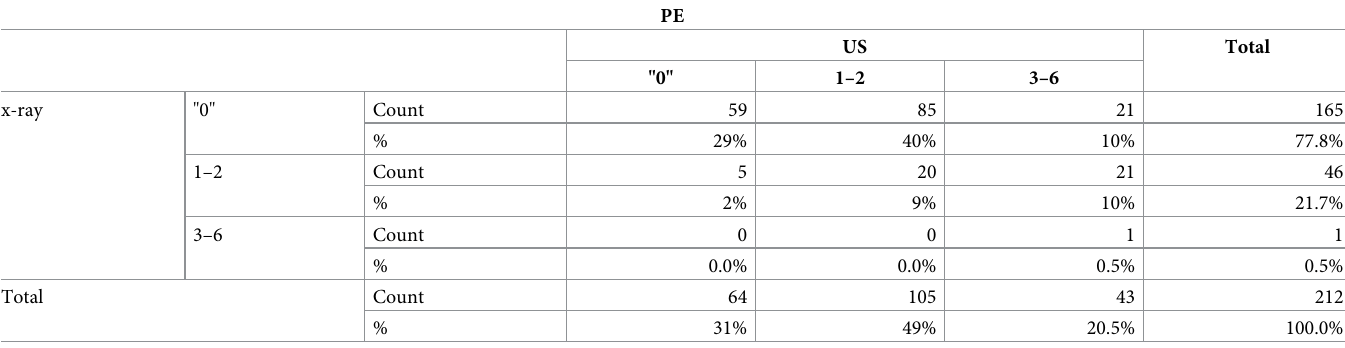
Table 3. PE: The agreement between LU and CXRs by severity, the "precise method".